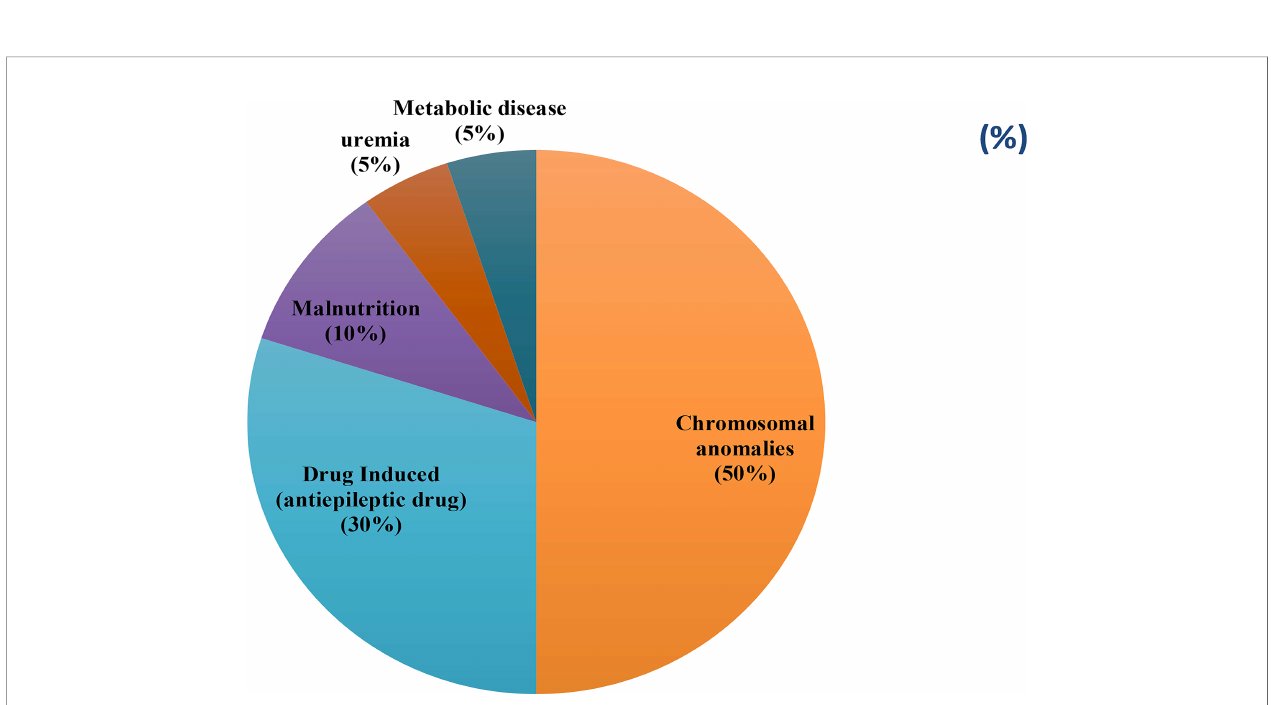
FIGURE 2 | The diagnosis of the patients with